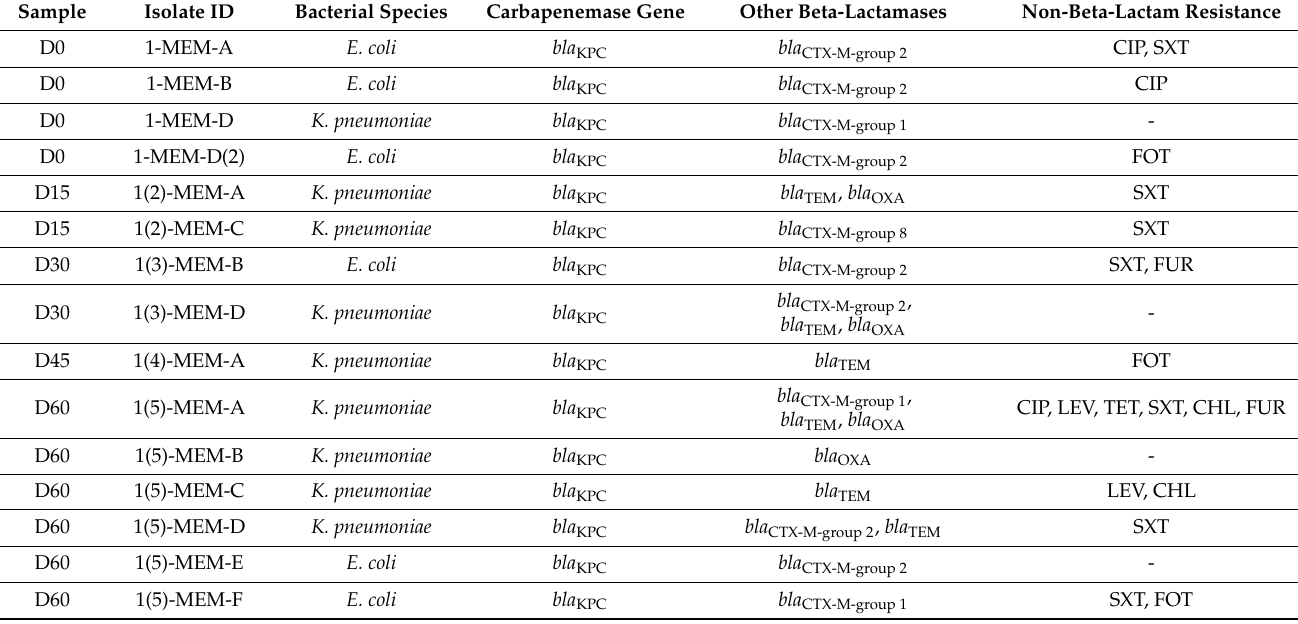
Table 1. Identification of the 15 isolates per sample, bacterial specie, carbapenemase gene, other beta-lactamases and non-beta-lactamases